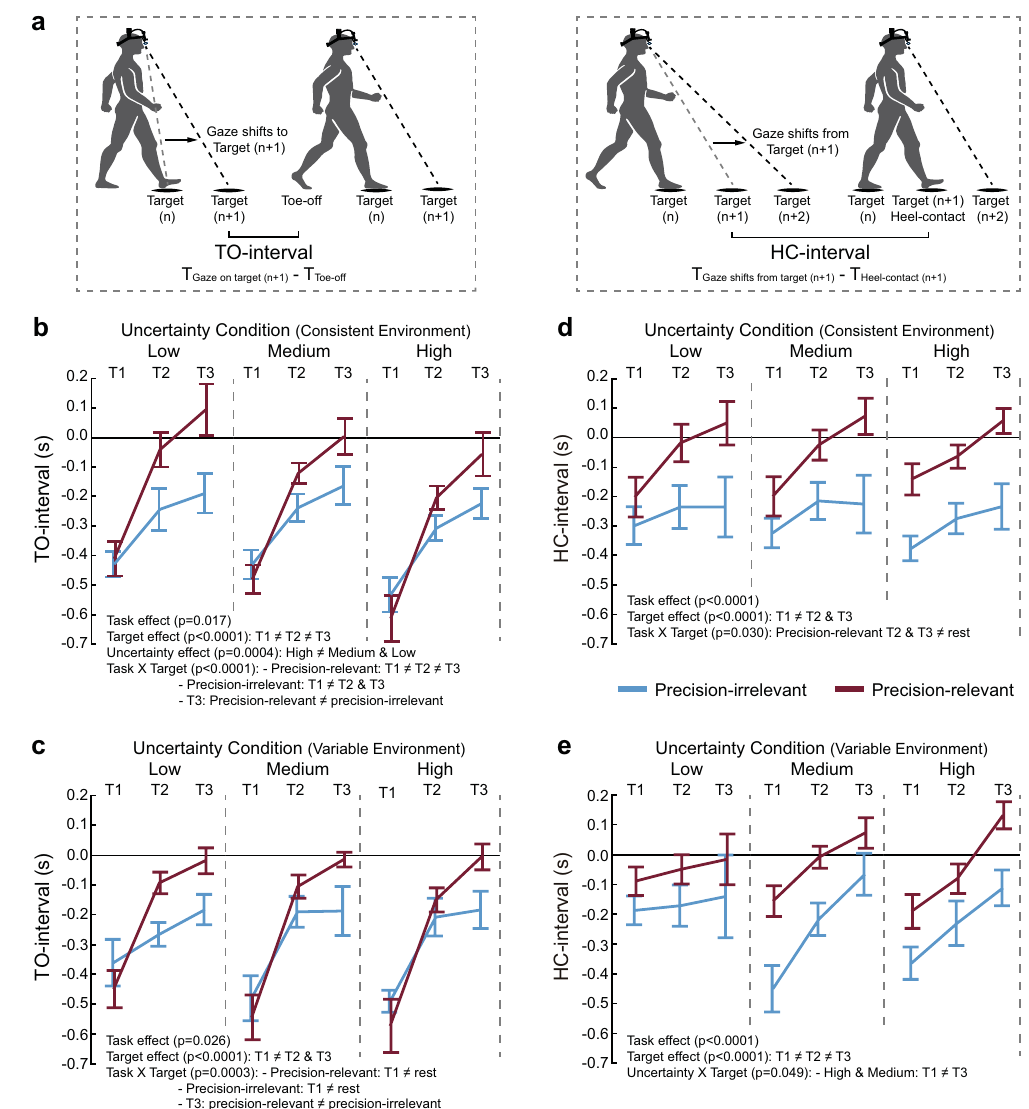
Figure 5. Gaze-foot spatial-temporal coupling. ( a ) The toe-off interval (TO-interval) is the time at which the subject fixates the target minus the time of TO for stepping on it, where negative values indicate a saccade and subsequent fixation made to the target before TO. The heel contact interval (HC-interval) is the time at which a subject saccades away from the stepping target minus the time of HC on that target, where negative values indicate a saccade away before HC on the target. Illustrated are the TO-intervals across uncertainty conditions, tasks, and target number for the consistent ( b ) and the variable ( c ) environments. Also illustrated are the HC- intervals across uncertainty conditions, tasks, and target number for the consistent ( d ) and the variable ( e ) environments. Data are represented as mean ± SE. Person illustrations by Amanda Bakkum in (a) used with